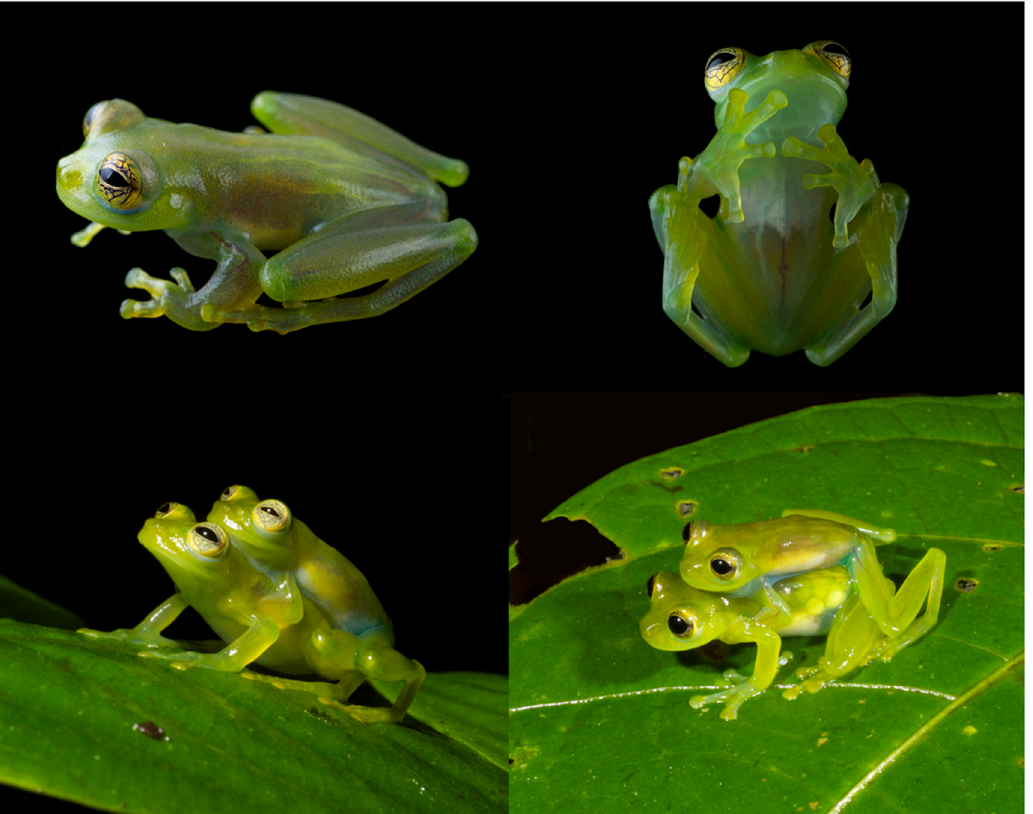
Figure 218. Teratohyla spinosa in life. Top row : Adult male from Durango, Esmeraldas province, QCAZ 45410. Bottom row : Amplectant pair from Reserva Otokiki, Esmeraldas province, Ecuador. Photos by Luis A. Coloma.